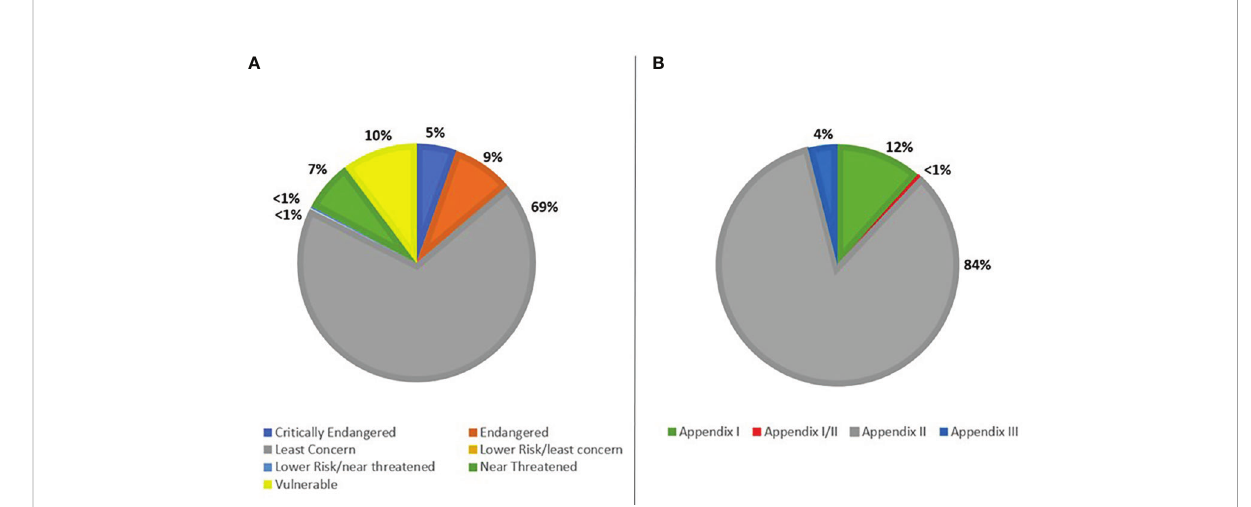
FIGURE 1 (A) Number of species listed in each of the IUCN Red List categories, within our search terms (B) Number of fauna species listed in each of the CITES